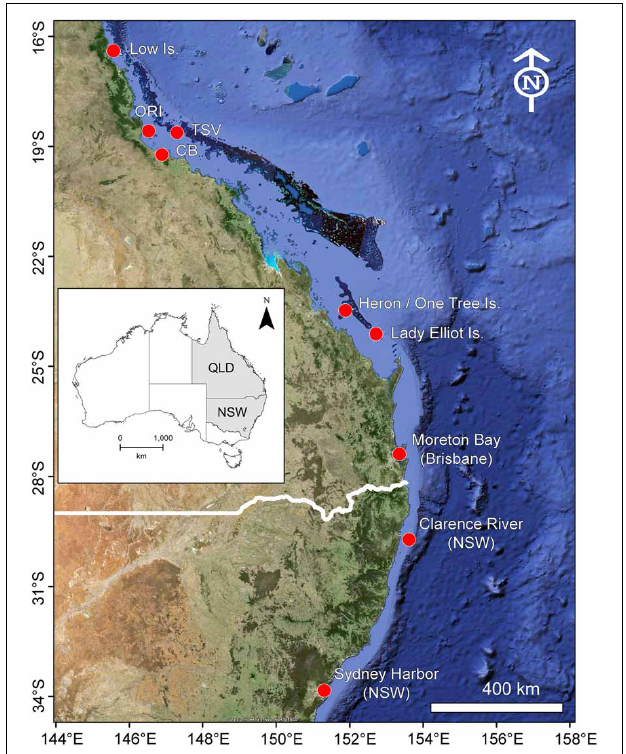
FIGURE 1 | Location of acoustic telemetry arrays along the east coast of Australia. White line indicates the QLD/NSW border.